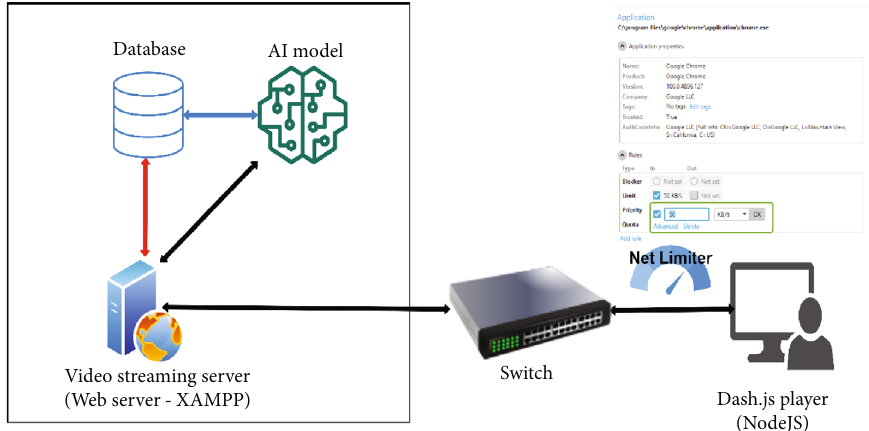
Figure 5: Experiment environment